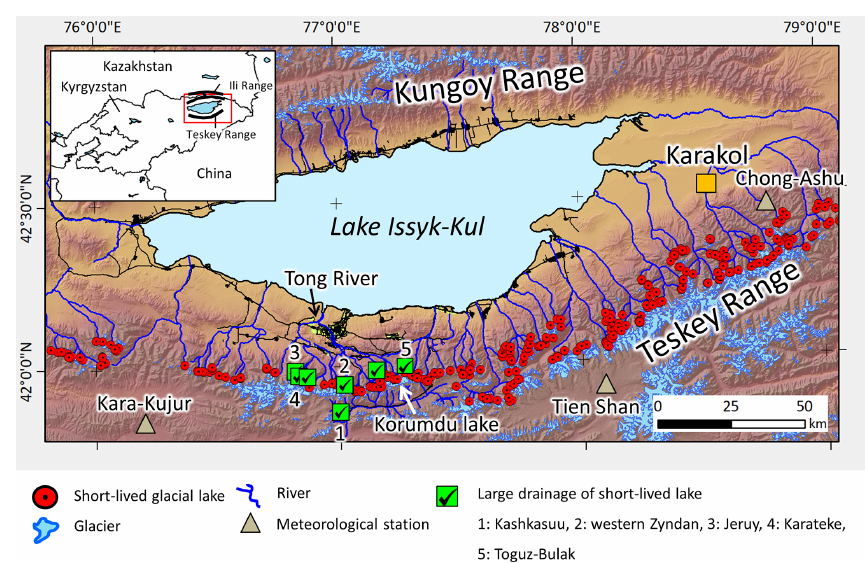
Figure 1. Study area in the northern part of the Teskey Range located on the south of Lake Issyk-Kul, Kyrgyz Republic. Red circles indicate locations of short-lived glacial lakes that appeared in 2013–2018. Green squares with checks show short-lived glacial lakes that have caused large drainage events since the 1970s. The shaded relief map was created using a Shuttle Radar Topography Mission (SRTM) digital elevation model (DEM).